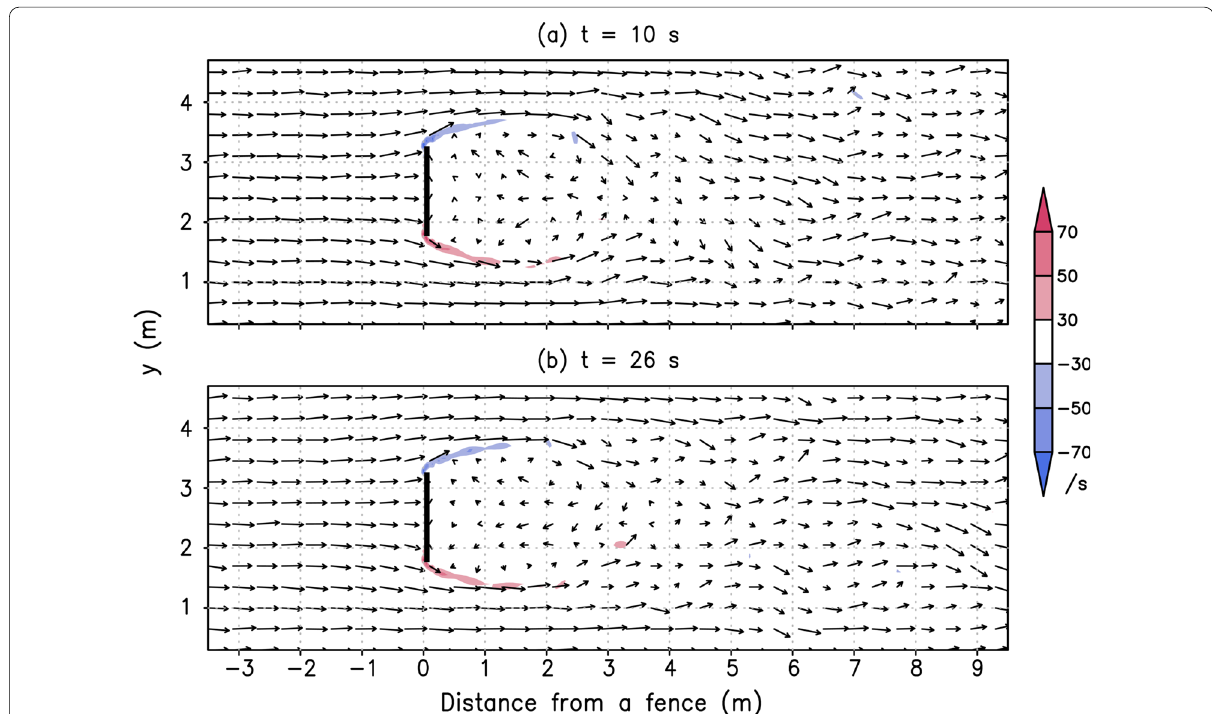
Fig. 10 Snapshots of wind vectors (vectors) and vorticity (shading) around the three-dimensional fence on the horizontal plane along z a 10 and b 26 s. The position of the fence is shown by a solid line